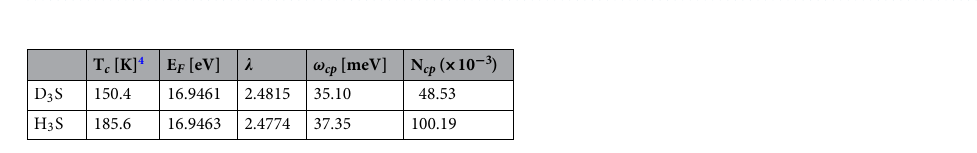
Table 2. Superconductor properties of D 3 S and H 3 S calculated at 180